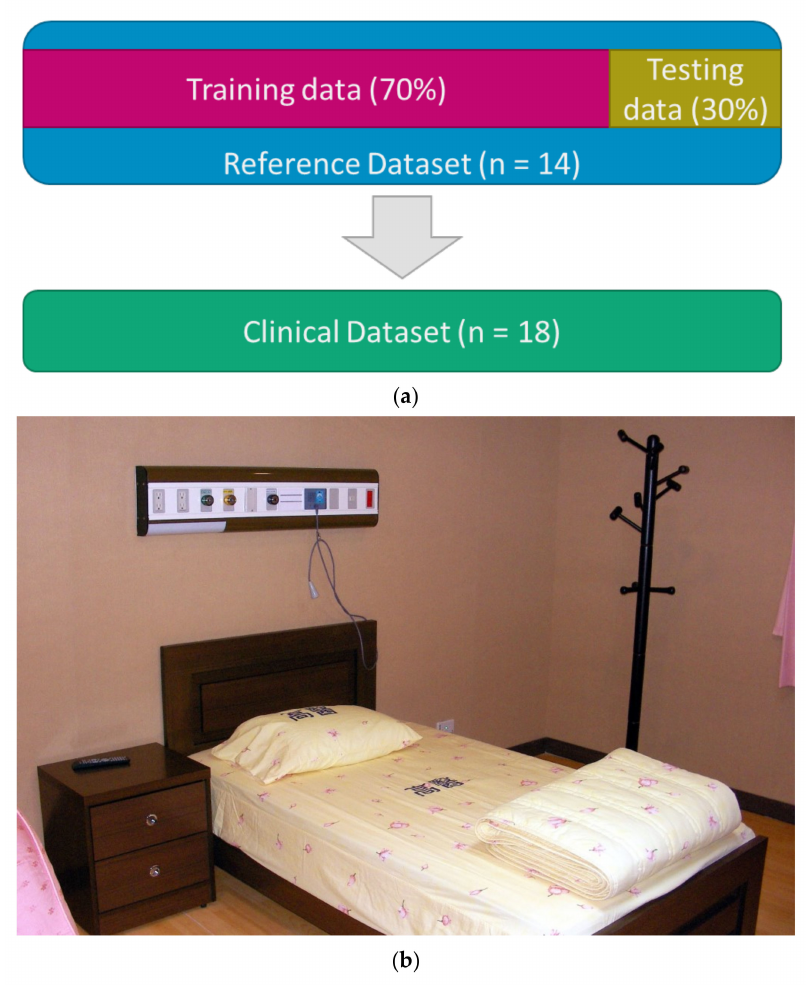
Figure 1. Experimental design for this study. ( a ) Experimental flowchart. The machine learning model is trained on a Reference dataset (n = 14) first. The train/test split of the Reference dataset was 7:3. After the model was trained, it was validated against a Clinical dataset (n = 17); ( b ) The PSG records were collected in a clinical environment from sleep labs of the Kaohsiung Medical University